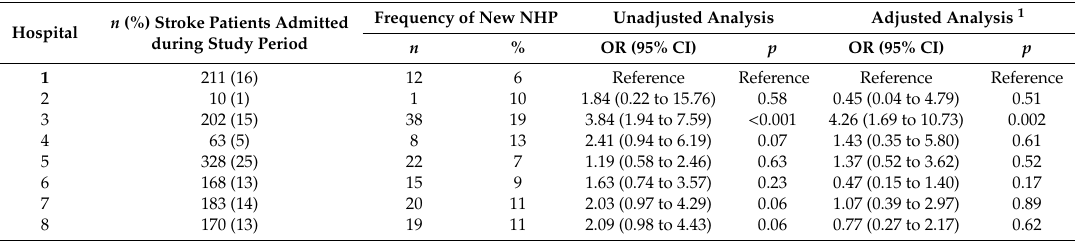
Table 1. Frequency of patients with stroke admitted and discharged to a nursing home placement (NHP) per hospital, and unadjusted odds ratio (OR) and 95% confidence intervals (CI) for new nursing home placement according to hospital ( n = 1335).